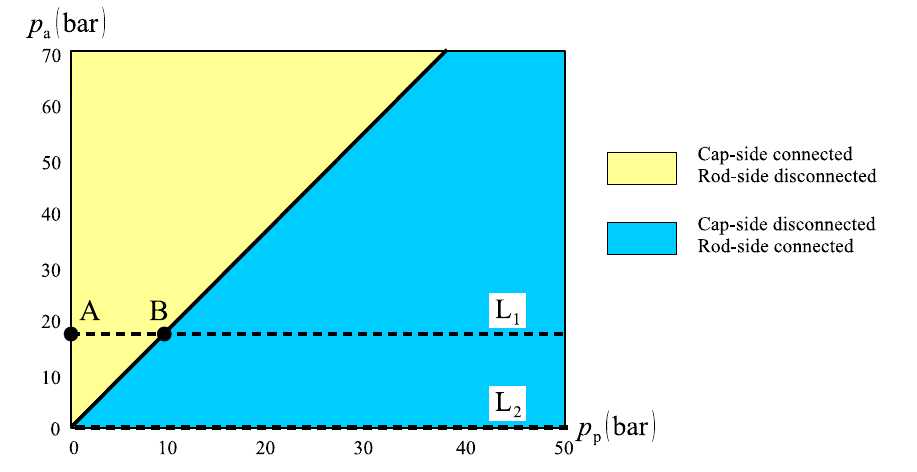
Figure 26. Logic valve circuit connections.